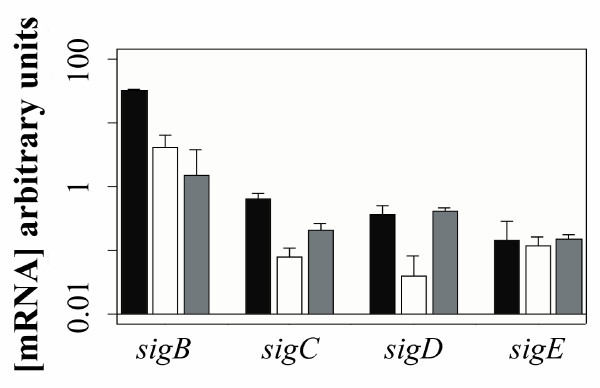
Trascription of sig genes during normal growth. Measurement of relative concentrations of sigB, sigC, sigD and sigE mRNAs in Synechocystis by quantitative RT-PCR during three stages of normal growth: mid log phase in black (A750 = 1); early stationary phase in white (A750 = 8); and late stationary phase in grey (A750 = 12.6). Each sample was measured in triplicate and the standard deviation is indicated by error bars. Values were normalized to the rpoA transcript.